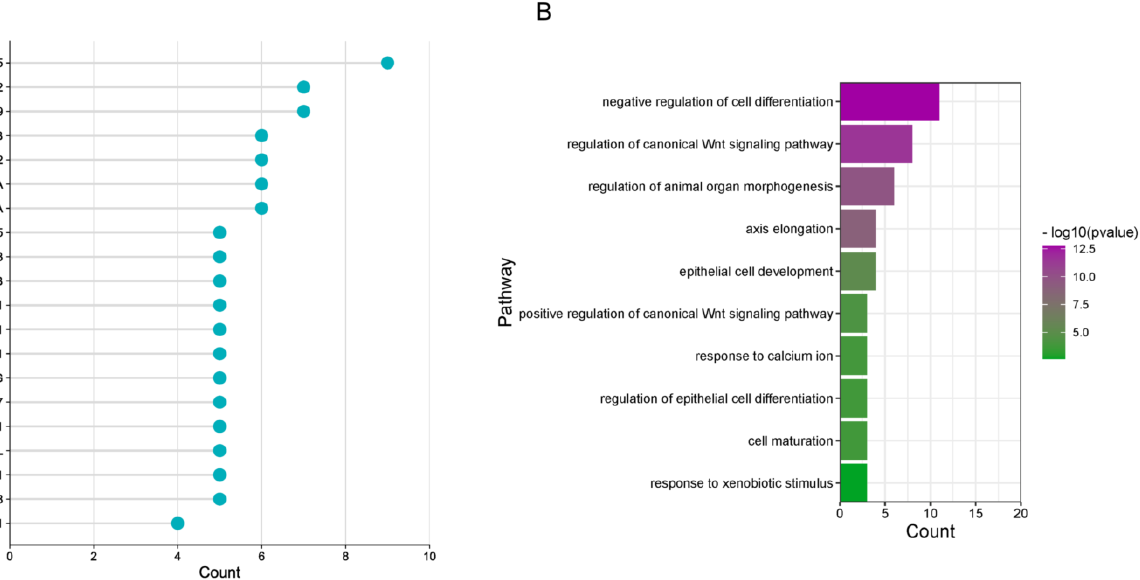
Given the well-characterized role of ERBB2 in breast cancer pathogenesis, we next analyzed breast cancer datasets available within the GEO database to determine if there are any similarities in the ERBB2 -mediated enrichment of pathways in breast and colon cancer patients. Two independent datasets from different populations were selected: GSE29431 Caucasian/Spanish and GSE48391 Asian/Chinese (Supplementary Figure S1). These two datasets did not include the IHC scores for HER2. When comparing our transcriptomics data with the HER2 IHC, we found them to correlate if we take the average transcriptomics expression of the ERBB2 mRNA. Therefore, we attempted to perform the stratification of HER2 from publicly available resources in a similar manner to the way we did with our patients’ cohort from the mRNA transcriptome data, by taking the average HER2 expression from each group and stratifying them as HER2+ and HER2 − accordingly. Therefore, followed by a quality control assessment based on HER2 expression in a particular patient compared to average HER2 expression in all patients within each cohort, 13 HER2 − and 8 HER2+ were selected from the GSE29431 dataset and 35 HER2 − and 9 HER2+ were selected from the GSE48391 dataset (Supplementary Table S6).